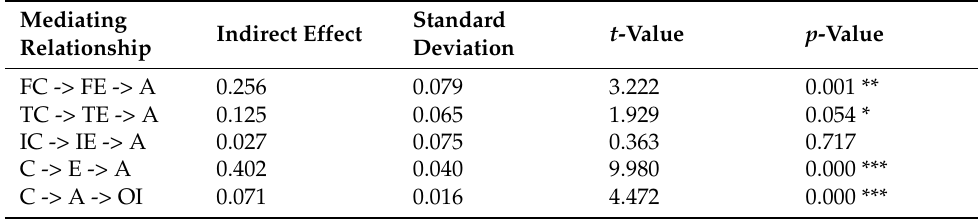
Table 11. Assessment of mediating